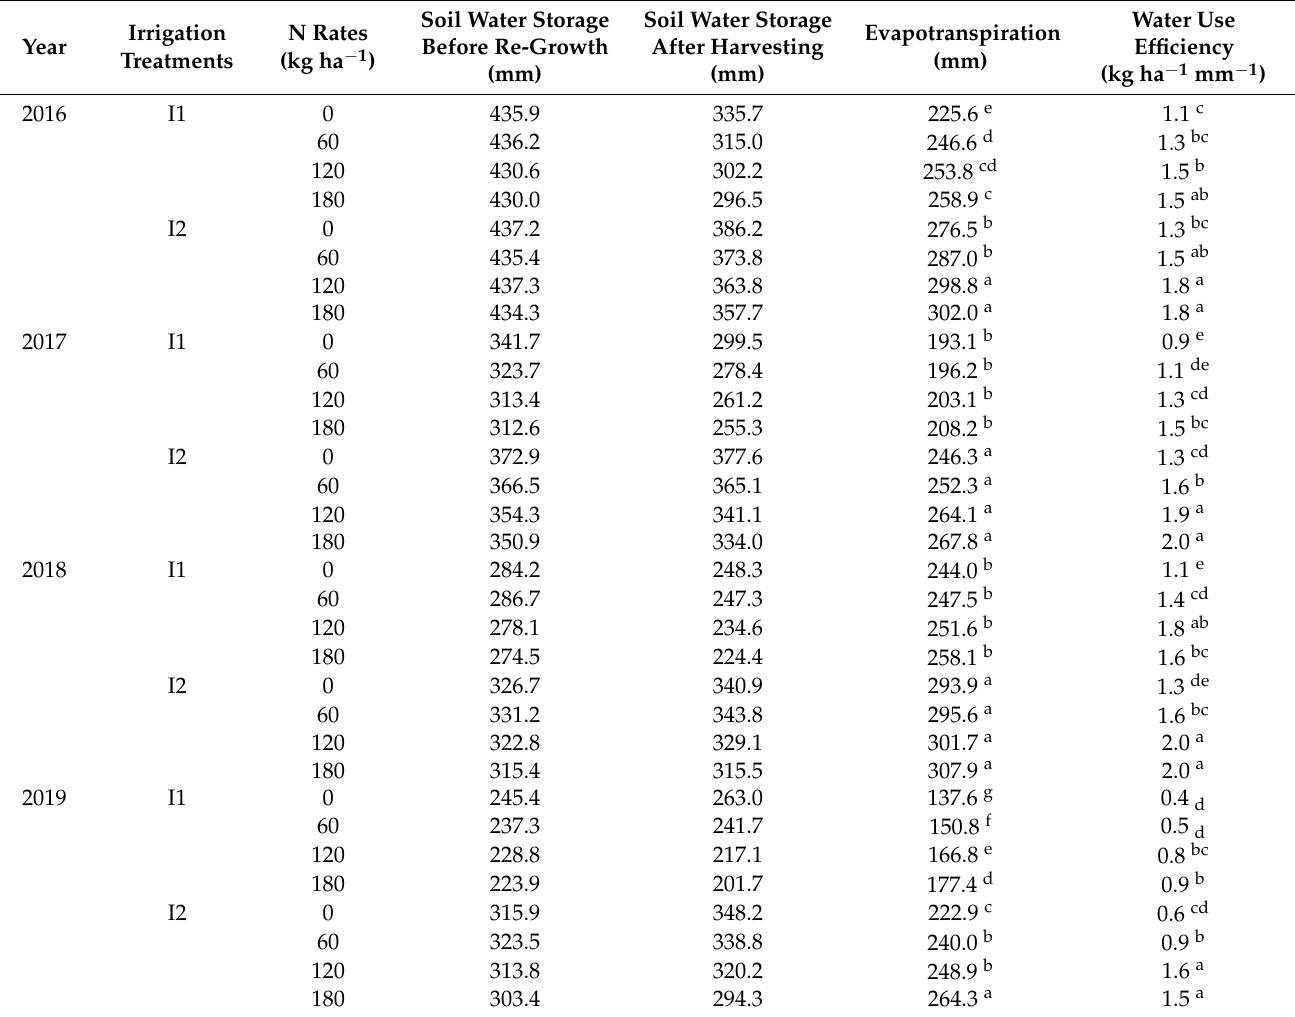
Table 4. Effects of different irrigation and N rate treatments on evapotranspiration and water use efficiency of Cleistogenes songorica seed crops from 2016 to